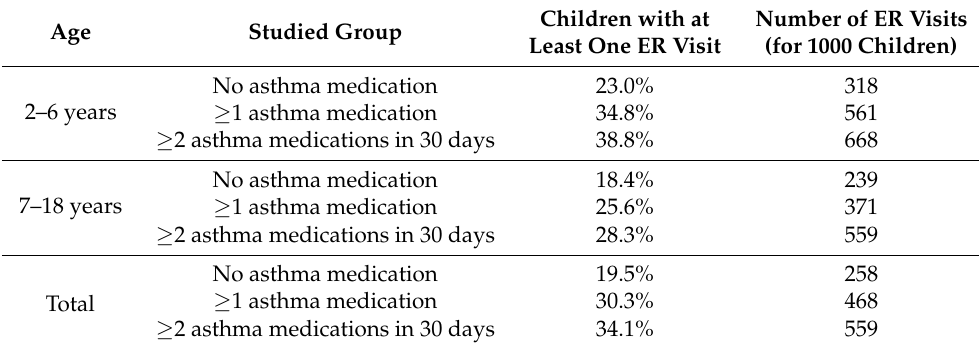
Table 4. Emergency-department visits for children based on asthma medication use and